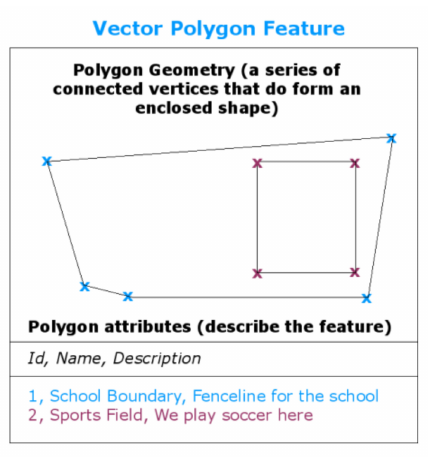
Figure 3. Polygon type vector